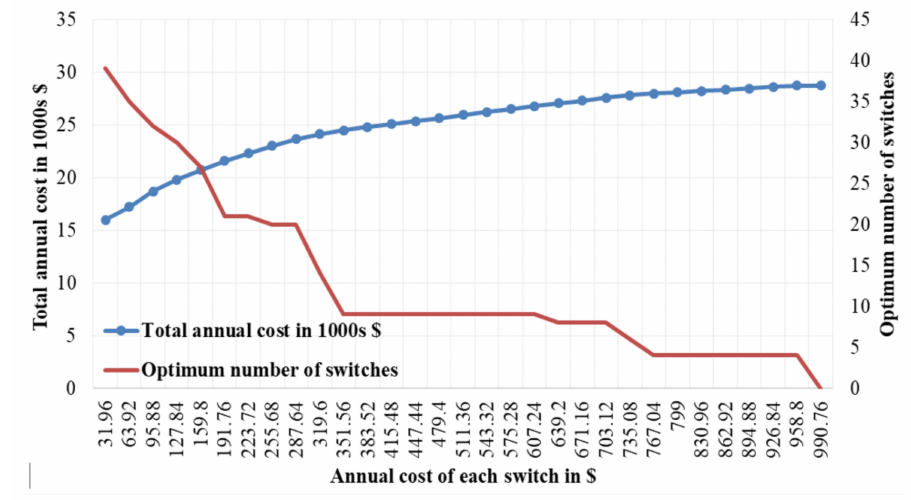
Figure 6. The effect of switch cost on the total annual cost and the optimum number of switches.